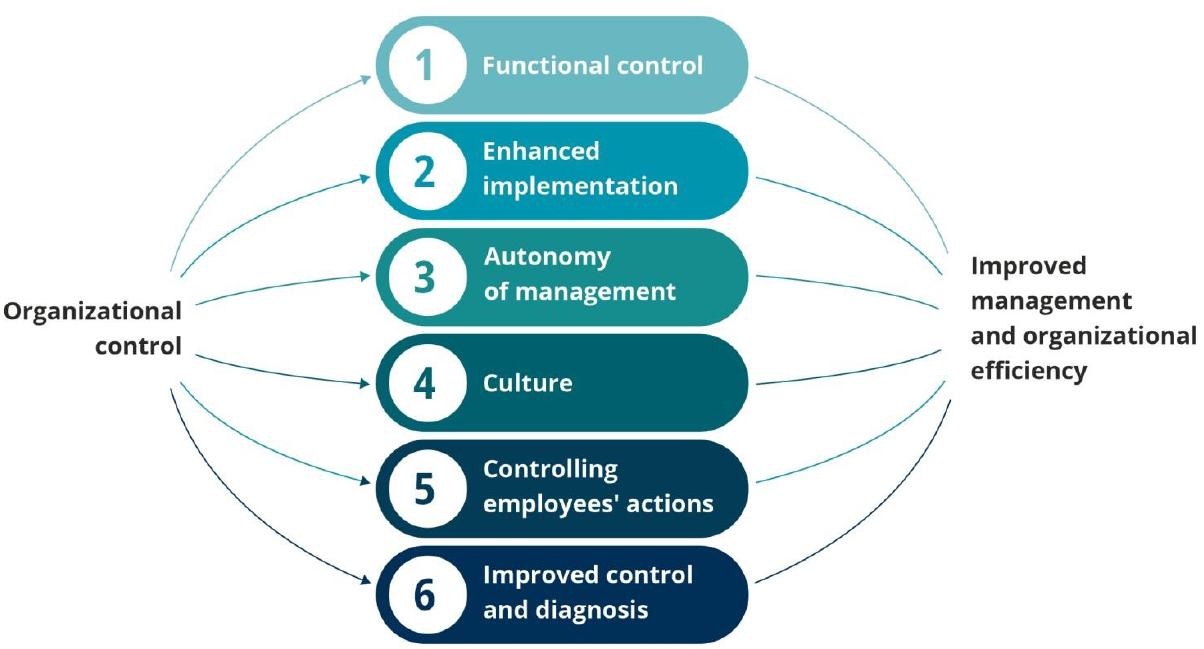
Figure 5. Research model and hypothesis